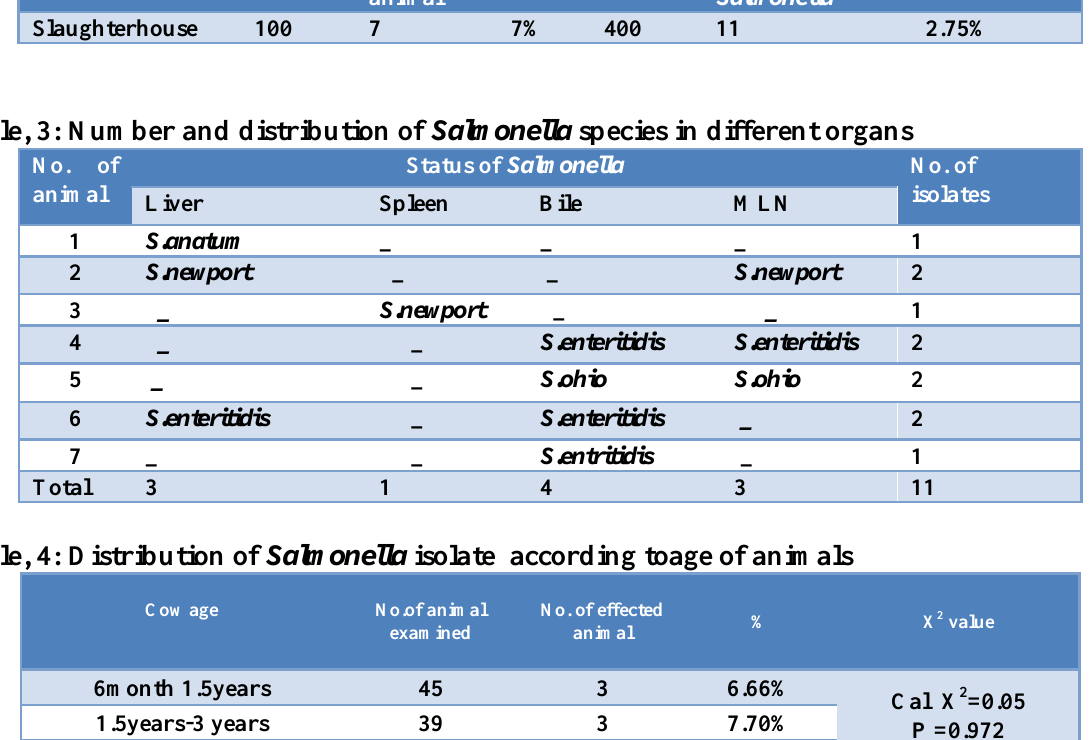
Table, 2: Percentage of infections with Salmonella in cow Location